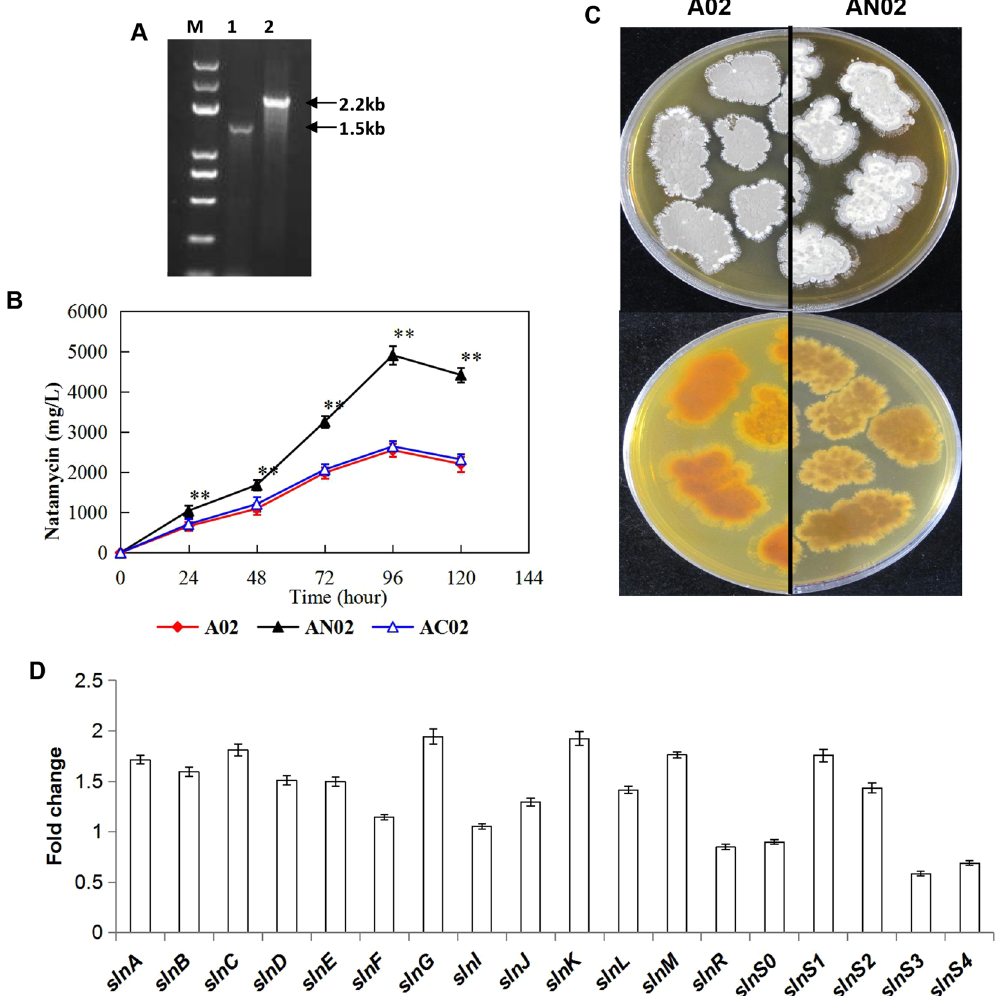
Figure 5. Effects of nsdA disruption on natamycin production and expression of the sln cluster in A02. ( A ) PCR verification of the nsdA mutant. Lane M, DNA Marker; Lane 1, Amplification with primers NP1 and NP2 in A02; Lane 2, Amplification with primers NP1 and NP2 in AN02. ( B ) Spore formation (upper) and pigment production (lower) of the A02 and AN02 on PDA plates but different sides for 10 days. ( C ) Natamycin production in the A02, AN02, and AC02. The experiments were repeated three times, and the data shown are the mean ± SE; * P < 0.05, ** P < 0.01. ( D ) Expression of the genes of the sln cluster detected by qRT-PCR in A02 and